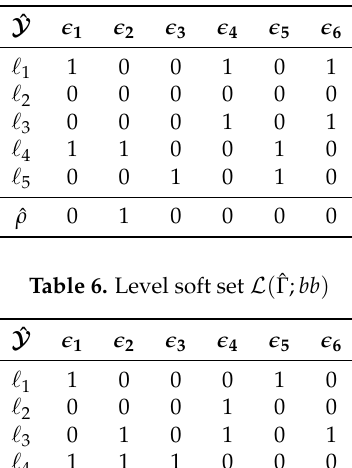
Table 5. Level soft set L ( ˆ Γ ; tt )